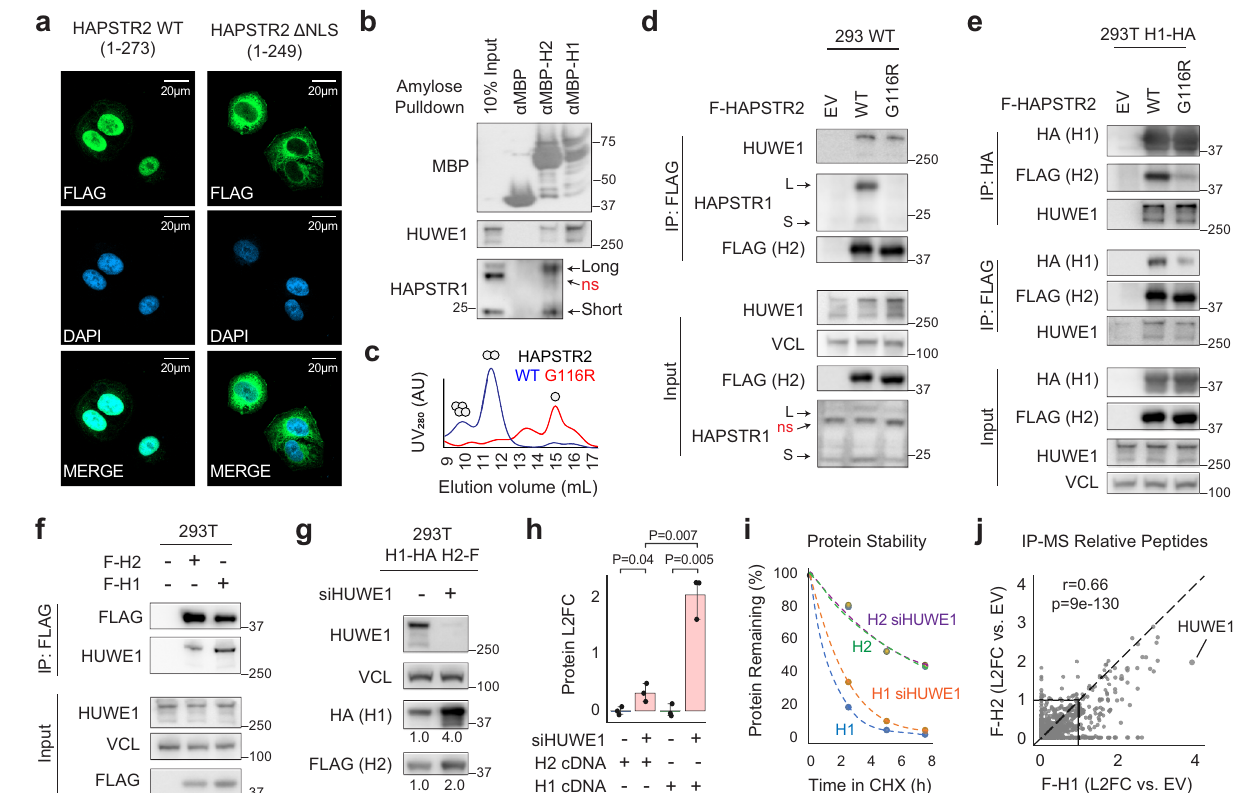
Fig.3|HAPSTR2retainsbiochemicalfeaturesofHAPSTR1butlessavidlybinds HUWE1. a HAPSTR2 localizes primarily to the nucleus ina manner dependent on a conserved C-terminal nuclear localization signal (NLS; residues 250 – 273). Field representativeofthreeindependentexperiments. b Isolationofpreyproteinsfrom 293T cell lysates using recombinant MBP, MBP-HAPSTR2 (H2), or MBP-HAPSTR1 (H1).NotethatHAPSTR1onimmunoblotappearsasalongandshortisoformwitha non-speci fi cband inbetween, and thatHAPSTR2co-puri fi esboth